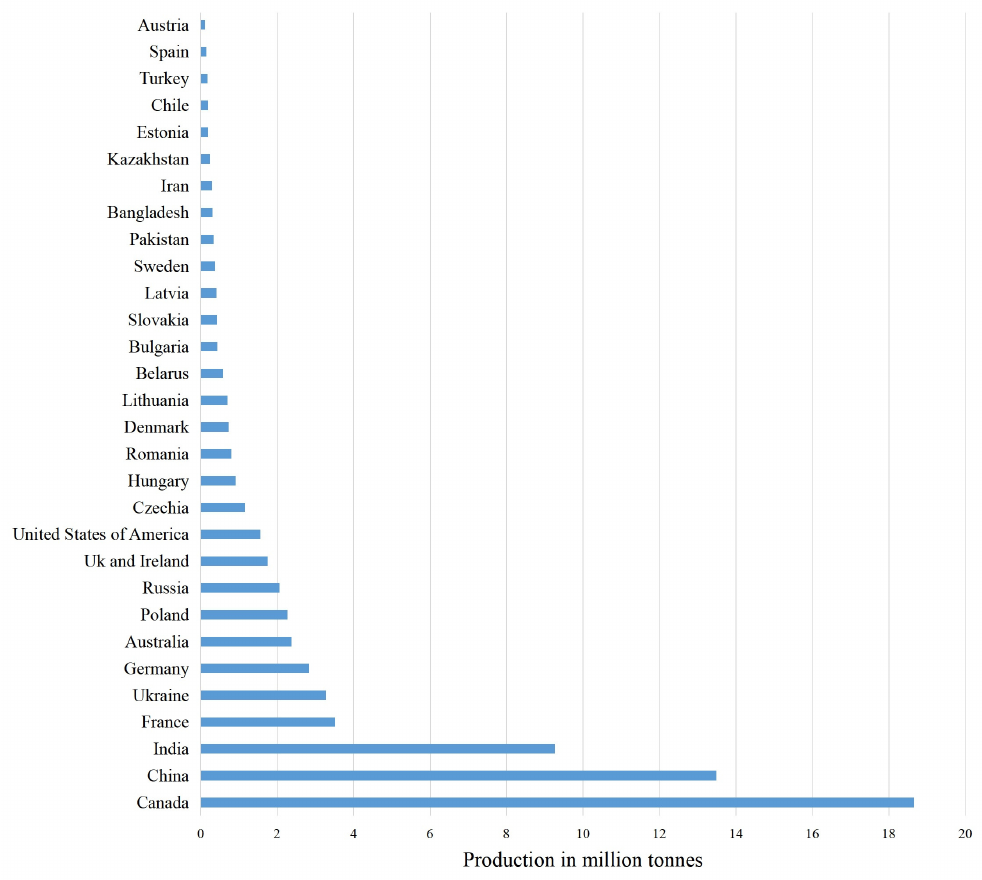
Figure 1. Worldwide rapeseed production in some main countries in year 2019